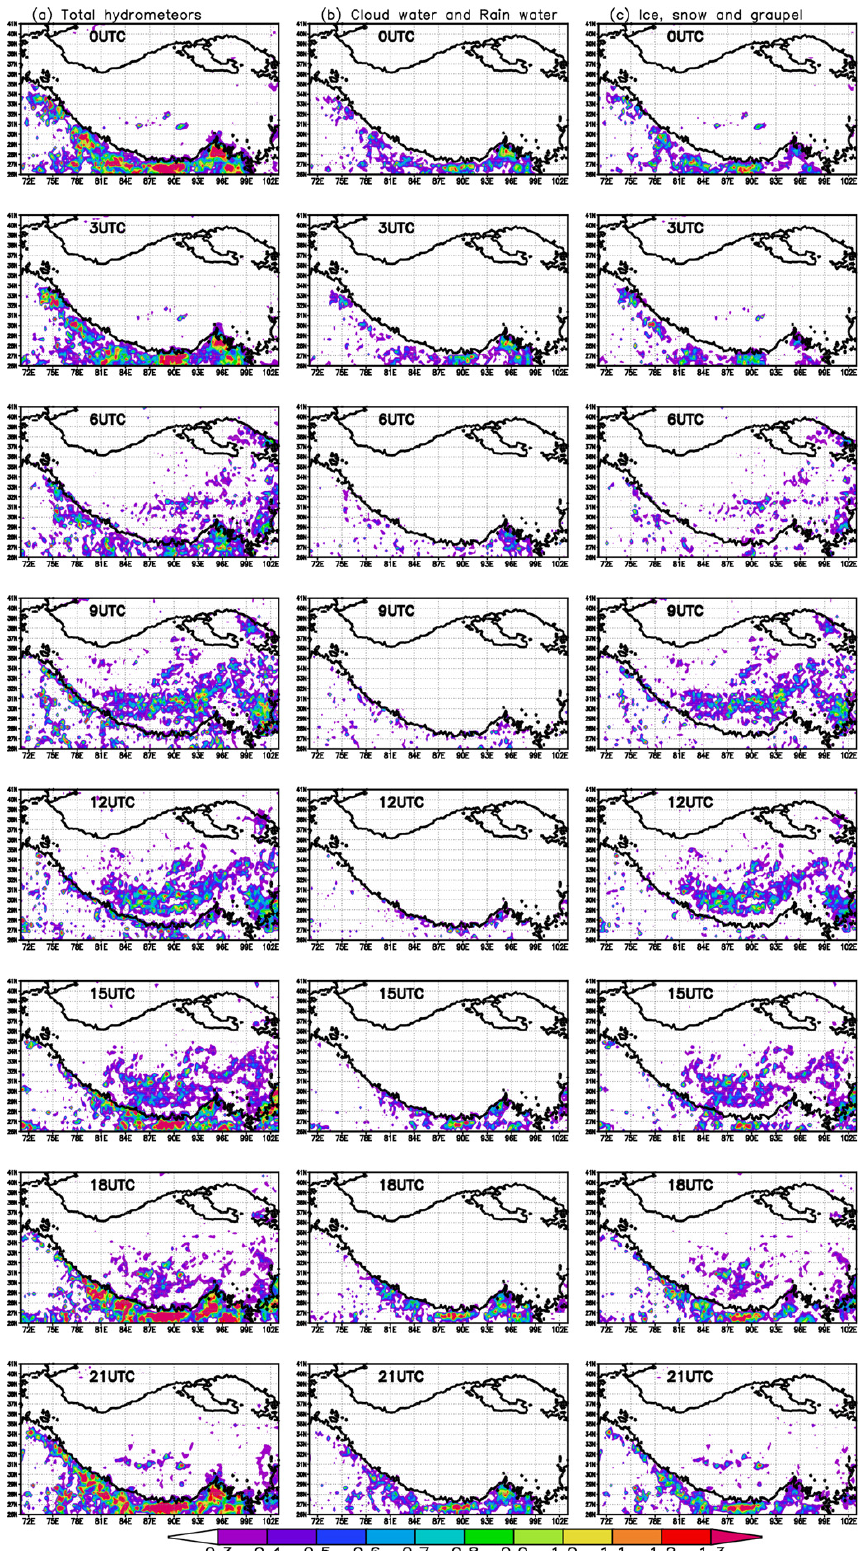
Fig. 9. Diurnal variation in vertically integrated hydrometeors (kgm − 2 ) : (a) total hydrometeors, (b) cloud water and rain water, (c) ice, snow and graupel. Solid lines indicate the 3000m